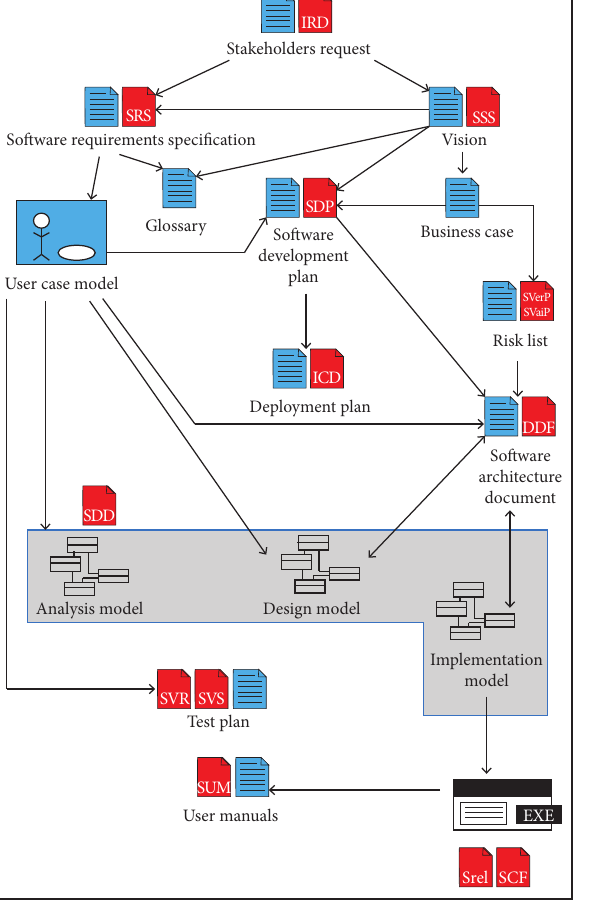
figure 11. H4ASD artifacts tree.